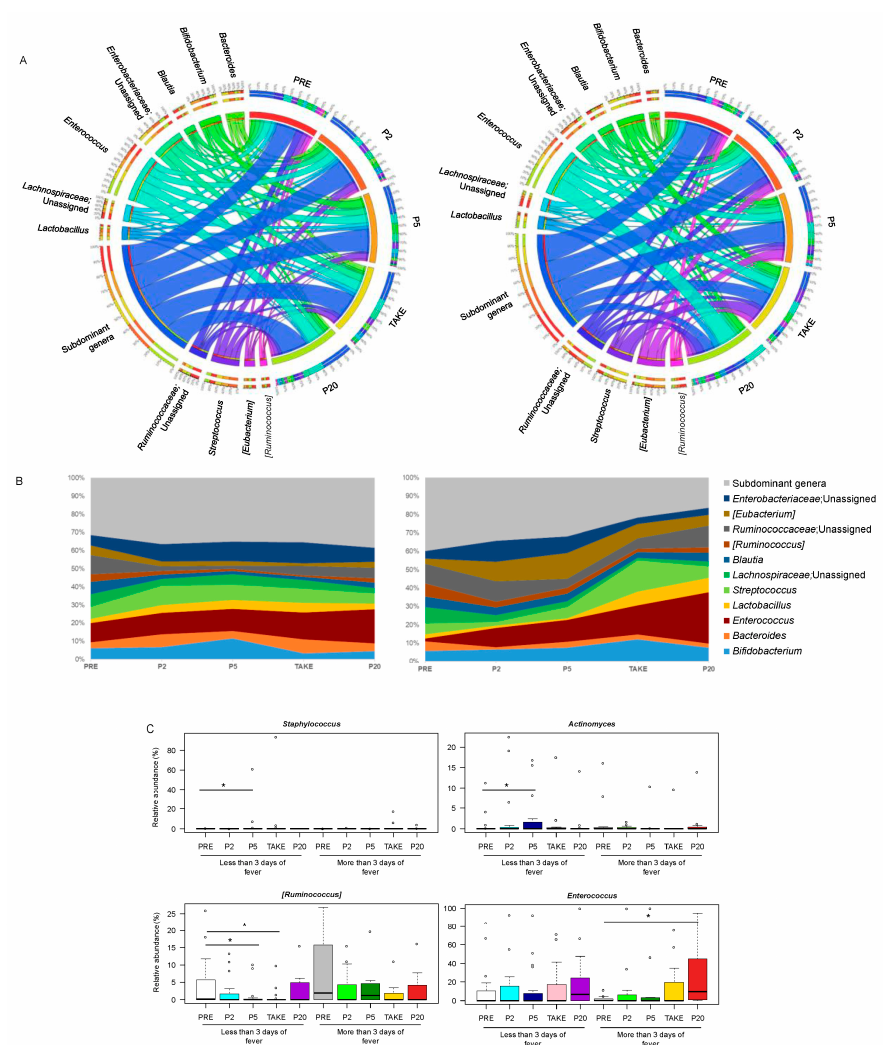
Figure 3. Genus-level gut microbiota trajectory in pediatric allo-HSCT patients with different duration of febrile neutropenia. Circos ( A ) and area ( B ) plots showing the relative abundance over time of the major genera in the GM of patients with less than or equal to (left) vs. more (right) than three days of fever. Only taxa with mean relative abundance > 20% in at least five samples of the total dataset are shown. PRE, before transplant; P2, at the onset of neutropenia (day − 2/+2); P5, at the onset of fever (day +4/+5); TAKE, at engraftment; P20, after engraftment (day +20/+30); ( C ) Boxplots showing the relative abundance distribution of genera significantly differentially represented over time in patients with different duration of fever. Wilcoxon test, * for p <